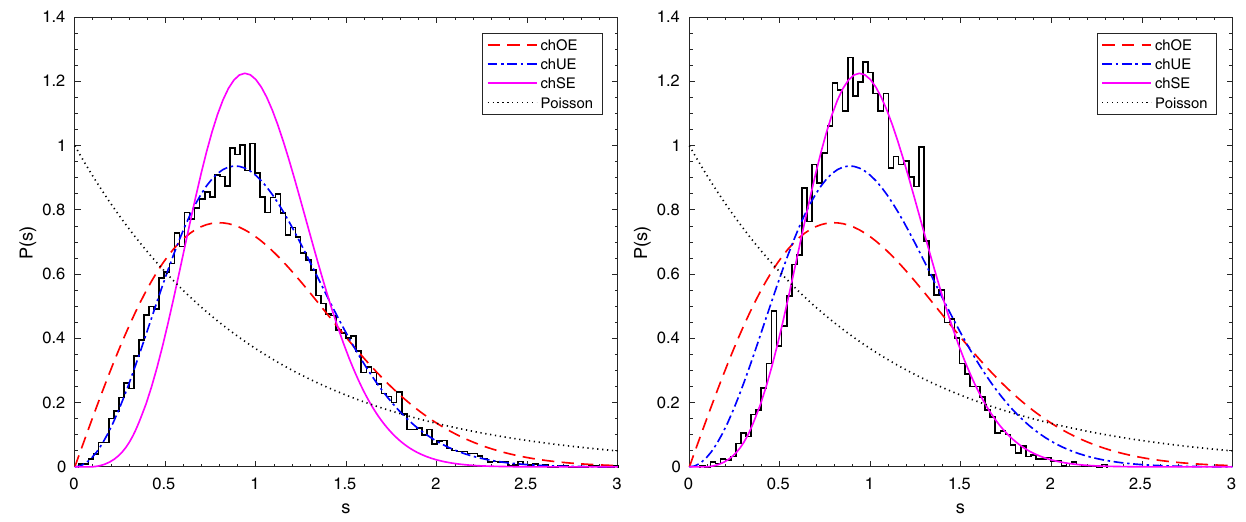
Fig. 4 Unfolded density of eigenvalue spacings obtained from spectra of the Wilson Dirac operator with a clover improvement term, for the fundamental (left-hand-side panel) and sextet (right-hand-side panel) representations of the SU ( 4 ) gauge group. The results were obtained from quenched simulations on a lattice of size ( L / a ) 4 = 4 for β = 10 . 0 and am 4 = am 6 = − 0 . 2. The numerical results are consistent with the Wigner surmise according to the symmetries of the operator, i.e. the